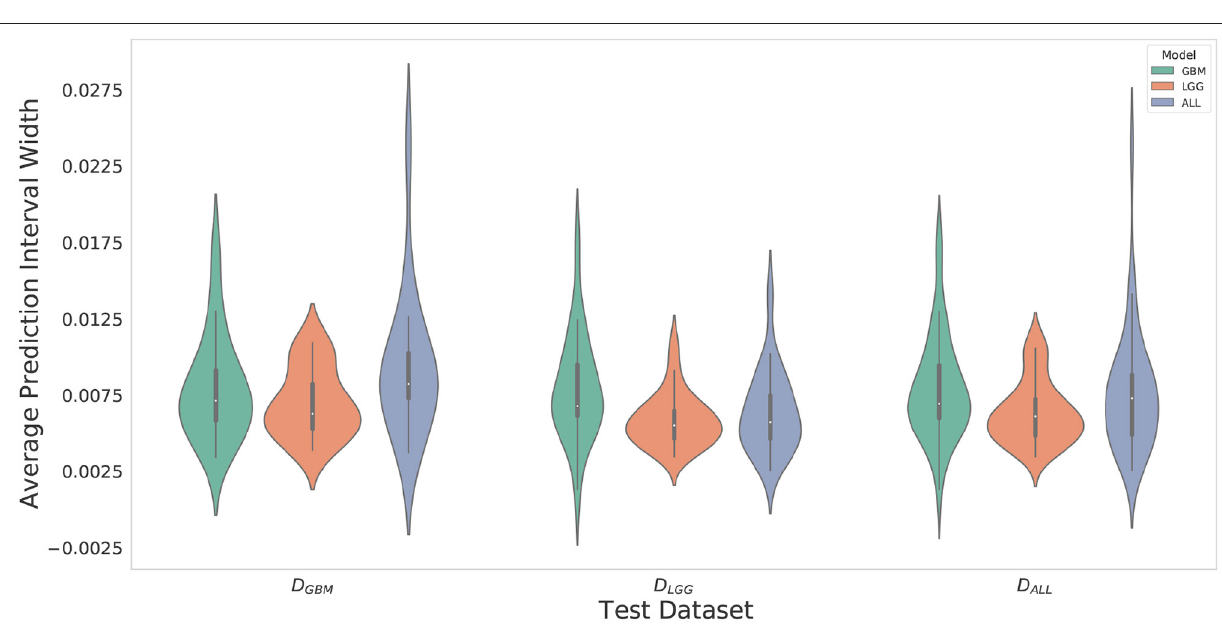
FIGURE 9 | Violin plots constructed to correct for effects of class imbalance and analyze model confidence while identifying tumor pixels only. Plots indicate models confidence is less consistent in identifying tumors due to wider inter-quartile range and greater spread of prediction interval distribution. Plot indicates M LGG is the most confident model while segmenting both LGG and GBM